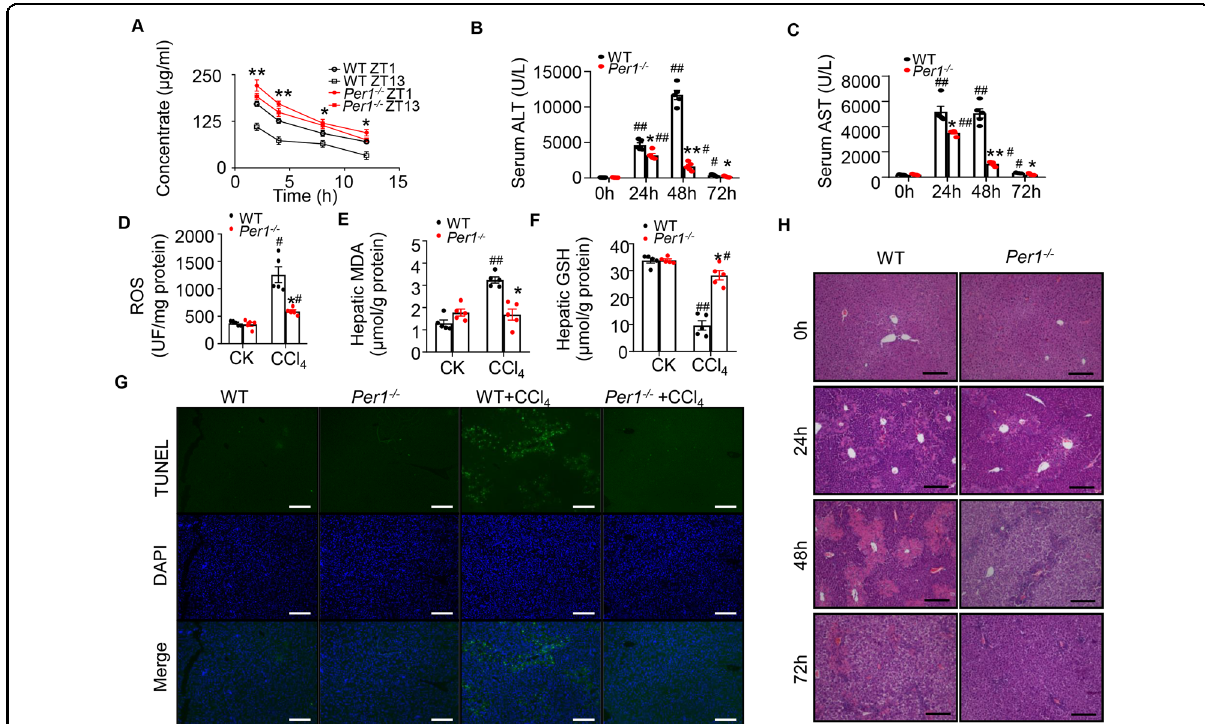
Fig. 3 Effect of Per1 de fi ciency on CCl4-induced acute liver injury in mice. A The time course of plasma CCI 4 concentrations from 0 to 12 h following a single intraperitoneal injection of CCl 4 (0.6 mL/kg body weight). B Serum activities of ALT and C AST at 24, 48, and 72 h after single CCl 4 treatment were measured. Liver tissues were collected 24, 48, and 72 h after single CCl 4 treatment. Hepatic concentrations of D ROS production, E MDA, and F GSH were measured 24 h after single CCl 4 treatment. G Representative immunostaining images. Apoptotic cells were visualized by TUNEL staining (green) and counterstained with DAPI (blue). H Representative H&E staining of livers from each treatment group. CK: control. Bar = 100 μ m. Representative images from N = 3 biological replicates. Data were shown as means ± S.E.M. N = 5 independent biological replicates per group. * indicates P value < 0.05, ** indicates P value < 0.01, Per1 − / − group versus WT group; # indicates P value < 0.05, ## indicates P value < 0.01, CCl 4 group versus control group. Data represent cumulative results from three independent